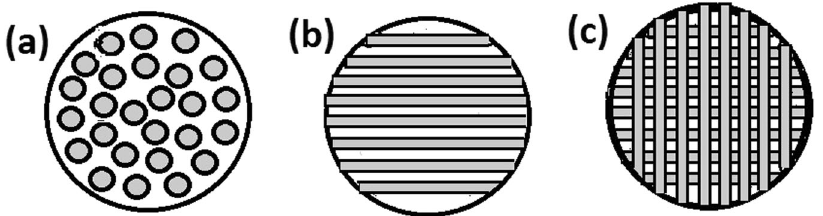
Fig. 1 Various presentations of carbon fi bers on the CFRP surface. Different possible presentations of carbon fi bres on CFRP surface, a unidirectional with fi bre ends exposed, b unidirectional with fi bre length exposed, and c a weave with fi bre lengths exposed (carbon fi bres are grey while polymer matrix is white).